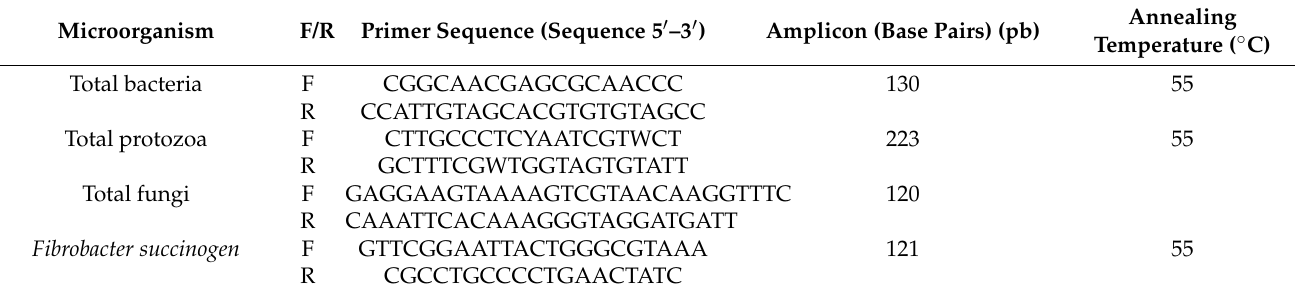
Table 3. PCR primers for real-time PCR